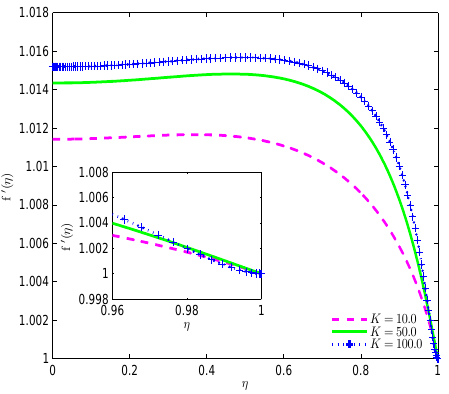
Fig. 4: Variation of f (cid:48) with γ at α = 0.01 , β = 0.005 , Re = 10.0 , K = 10.0 and Λ = 0.001 .